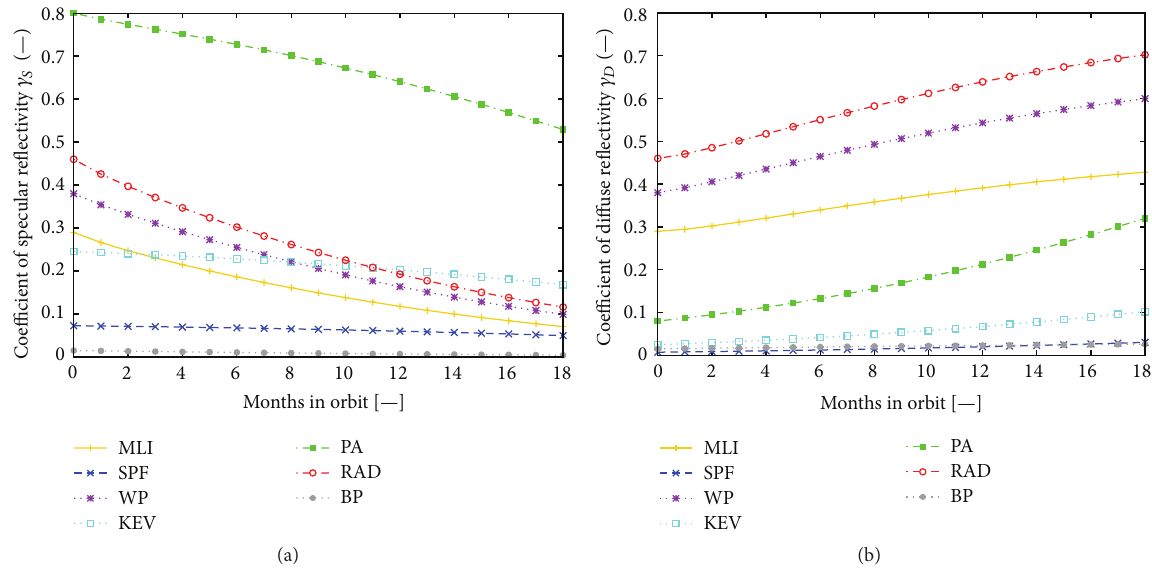
Figure 13: Considered variation of specular (a) and diffuse (b) reflectivity over mission lifetime of 18 months for chosen external components of MICROSCOPE test case. MLI: Multilayer Insulation, SPF: Solar Panel Front, WP: White Paint, KV: Kevlar, PA: Polished Aluminum, RAD: Radiator surface, and BP: Black